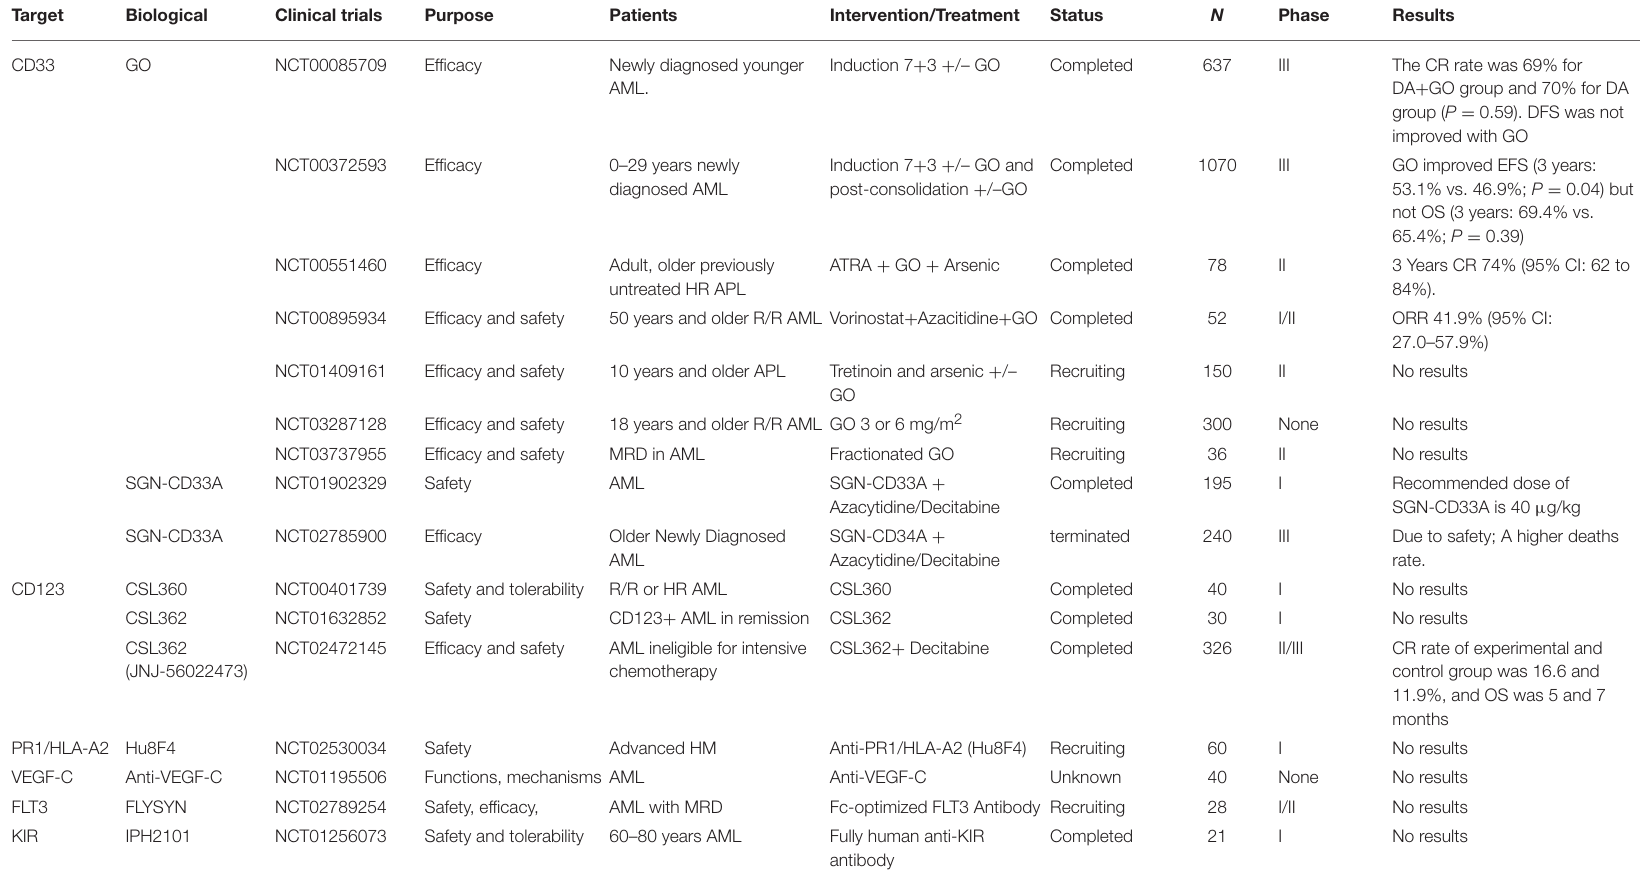
TABLE 1 | Selected completed or ongoing trials of antibody directed therapy for